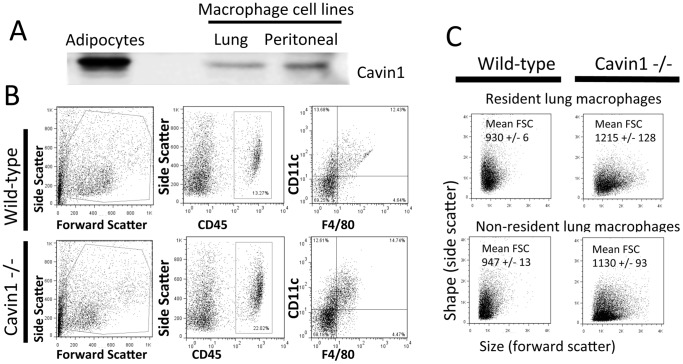
Morphological comparison of macrophages from lungs of wild-type and Cavin1−/− mice.A) Western blot analysis showed expression of Cavin1 in lung (MHS Cells) and peritoneal (RAW) macrophage cell lines. Relative concentrations were decreased when compared to Cavin1 levels in an adipocyte cell line (2 independent analyses). B) Flow cytometry analysis of lung digests from wild-type and Cavin1−/− mice after staining for F4/80 and CD11c (n = 3, both groups). Doublets, red blood cells and dead cells (propidium iodide positive) were excluded from analysis. C) Forward and side-scatter characteristics of resident (CD11c) and non-resident (CD11b+) macrophages in lung digests (n = 3 each group). Cell size (forward scatter) was significantly increased (p<0.05) in both resident and non-resident macrophages from Cavin1−/− mice.